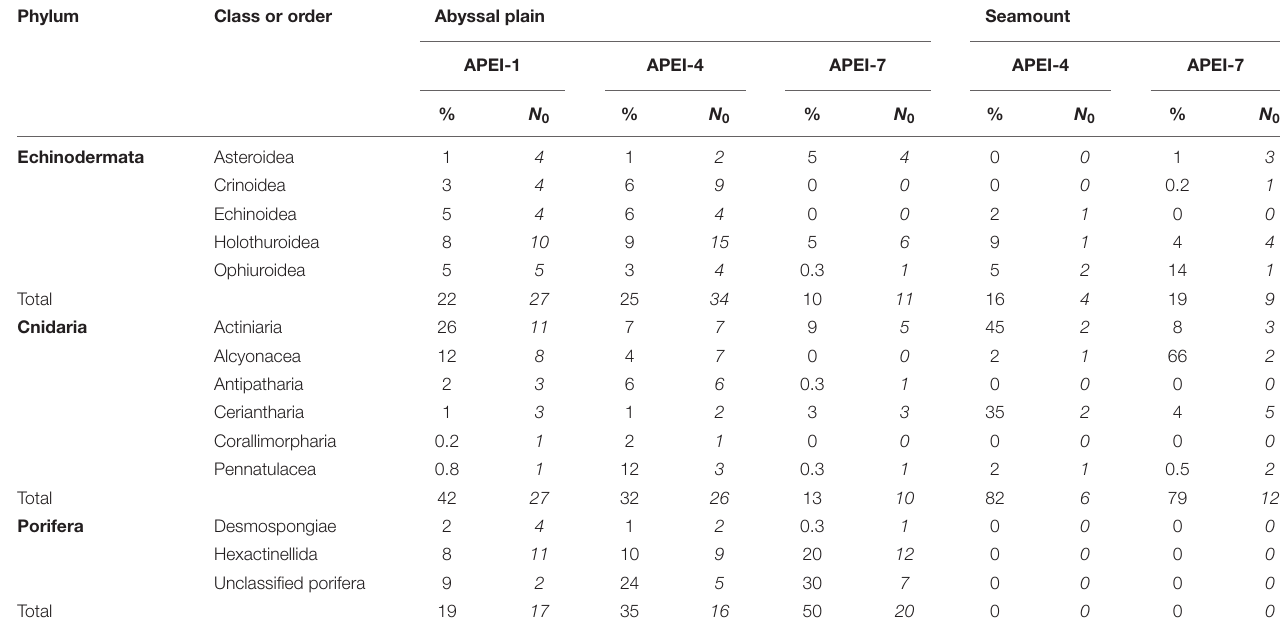
TABLE 4 | Contributions of major taxonomic groups to the metazoan invertebrate assemblage at the study sites: mean percentage of metazoan invertebrate density (%) and morphotype richness (N 0 ) over all sample units. Phylum Class or